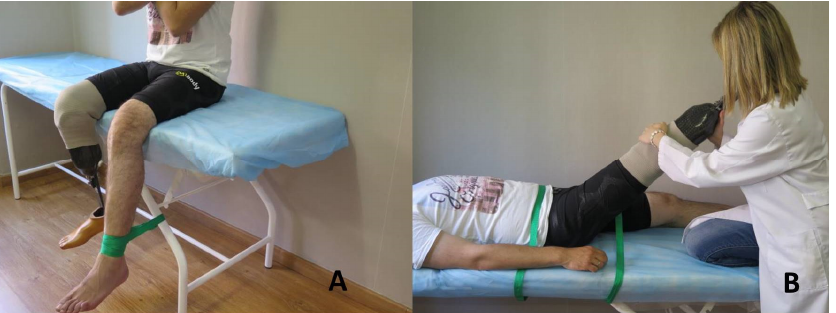
Figure 3. Recording of the maximum voluntary contraction (MVC). ( A ) Quadriceps group MVC record . ( B ) Hamstring group MVC record.